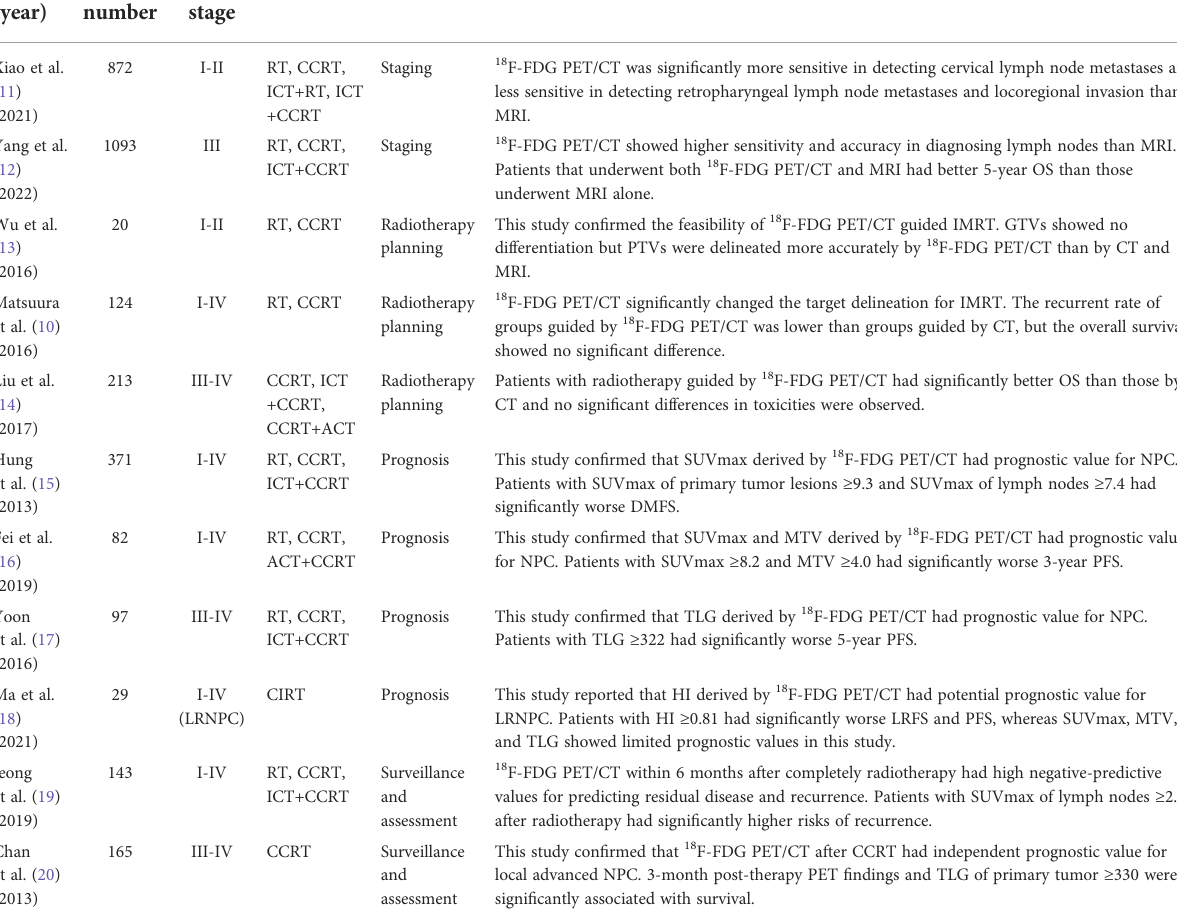
TABLE 1 Critical studies investigating 18 F-FDG PET/CT in